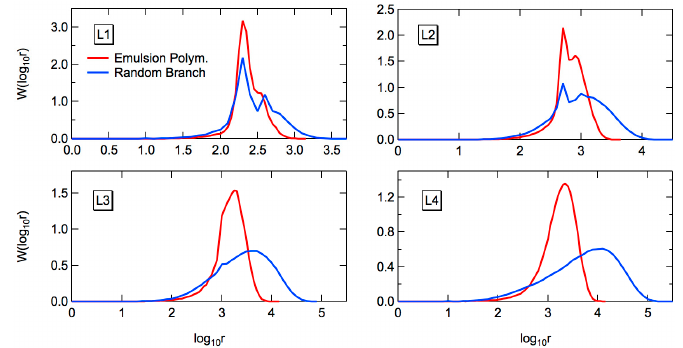
Figure 7. Comparison of the full weight fraction distribution profiles formed through the living emulsion polymerization for the conditions L1–L4 (red) and the corresponding random branching (blue).